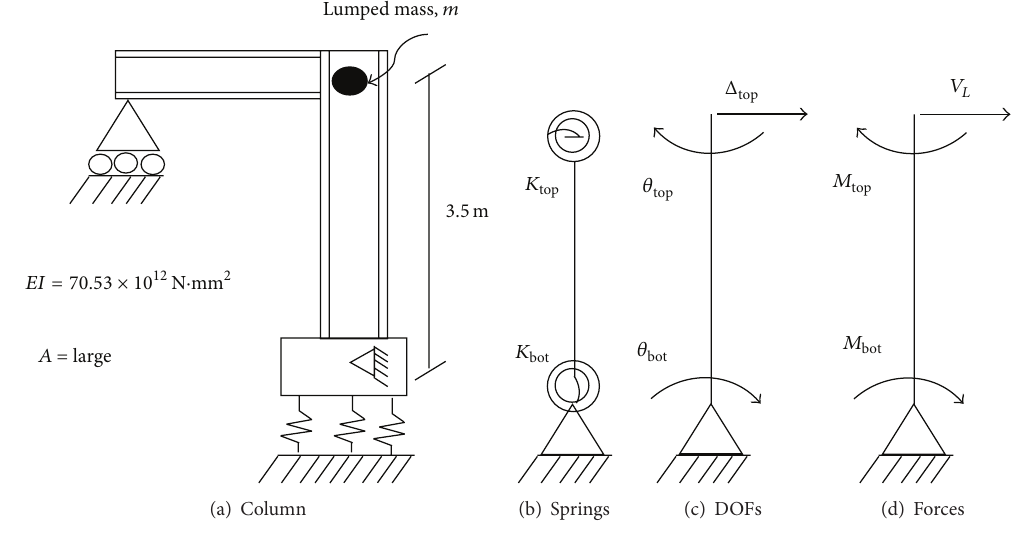
Figure 3: Analysis